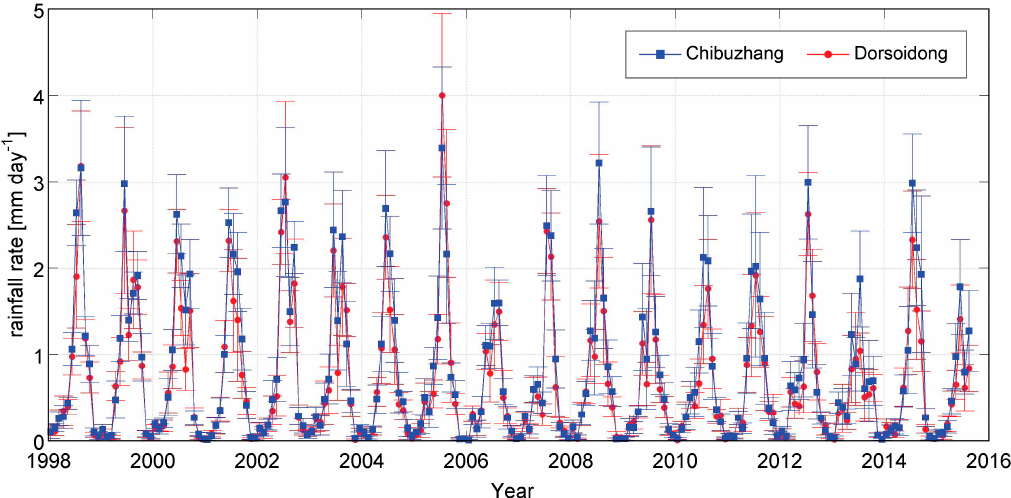
Figure 7. TRMM monthly solution of daily rainfall rate in two spatial boxes specified in Section 3.5. The blue line is for Chibuzhang Co and red line is for Dorsoidong Co. Error bars were computed from 1 σ of 16 grid values on each side.